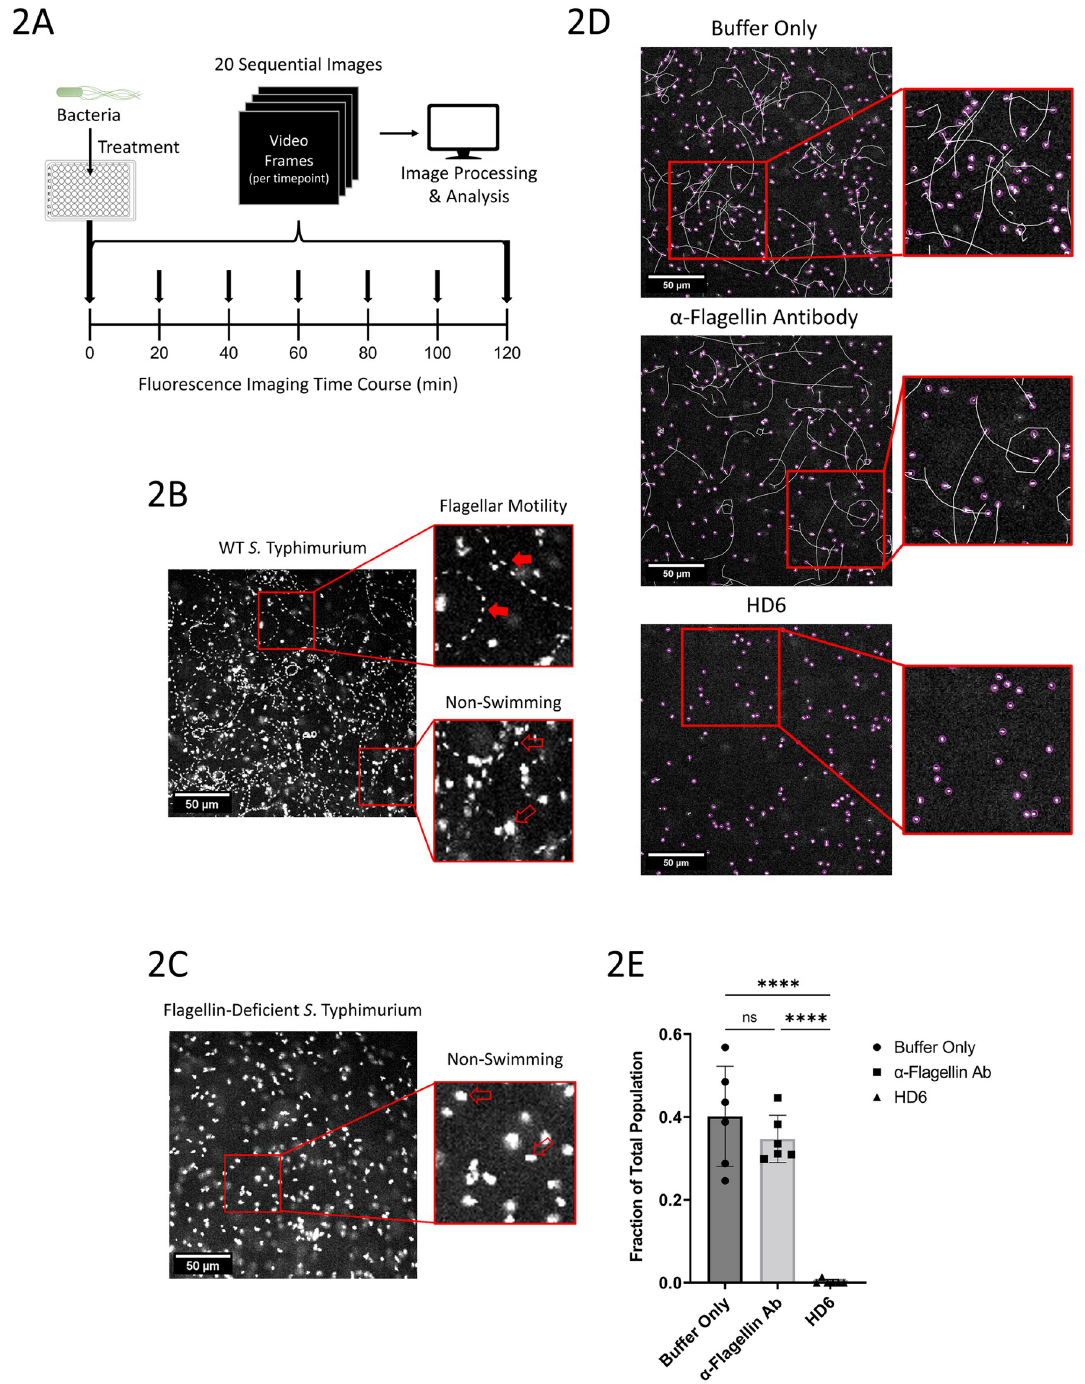
Fig 2. Live-fluorescence microscopy analysis of HD6 and α -FliC IgG effects on S . Typhimurium motility. ( A ) Schematic diagram depicting the workflow used for all live-fluorescence microscopy imaging experiments. Top Left, GFP-expressing S . Typhimurium are added to wells in a 96-well plate that containing different experimental treatments. Bottom, Images are captured at 20-minute intervals for each in-well position over the course of a 120-minute experiments, for a total capture of 7 timepoints. Top Right, At each timepoint, 20 sequential images are captured and Imaging data are then processed for analysis using Matlab and ImageJ. ( B ) Representative data captured at a single timepoint for GFP-expressing wild type (WT) S . Typhimurium in buffer. Data are presented as single superimposed image containing the 20 sequential images captured at a single timepoint, allowing for the detection of bacterial movement over time. Top Inset, Magnified image displaying an example of the characteristic pattern of S . Typhimurium moving via